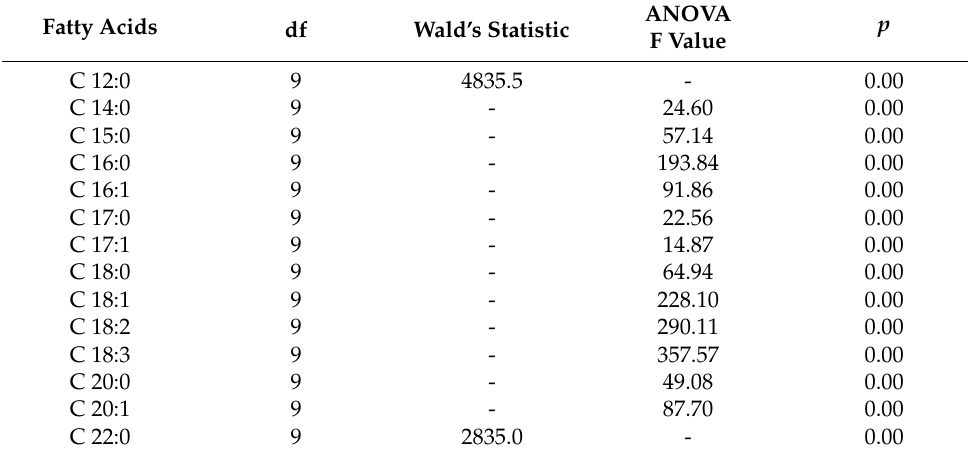
Table 2. Results of statistical assays (GLM, ANOVA) for the content of fatty acids in kernels of the analysed wheat